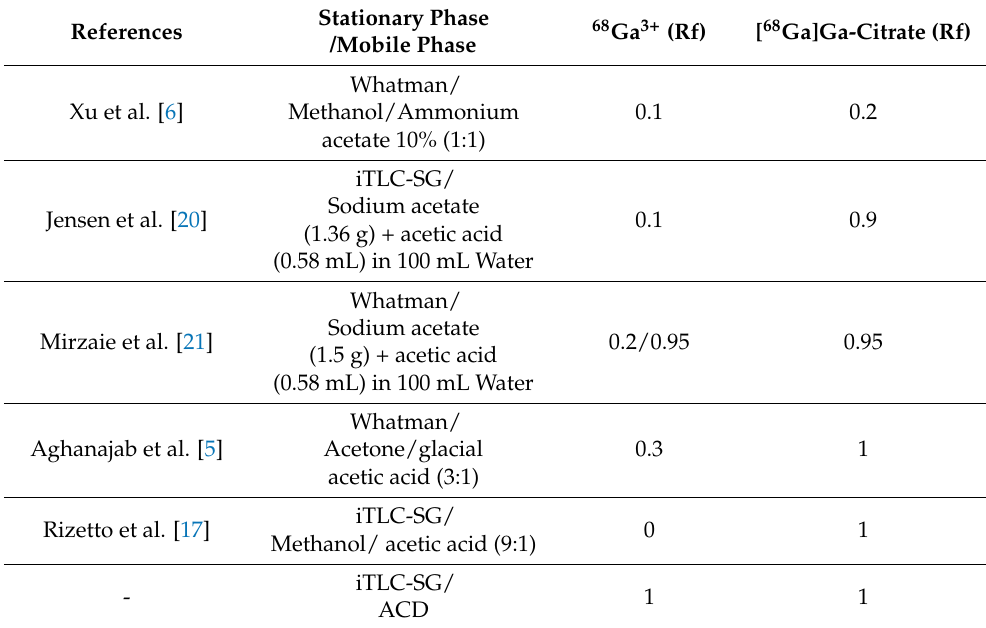
Table 6. Comparison of chromatographic properties of different systems tested for [ 68 Ga]Ga-citrate radiochemical purity